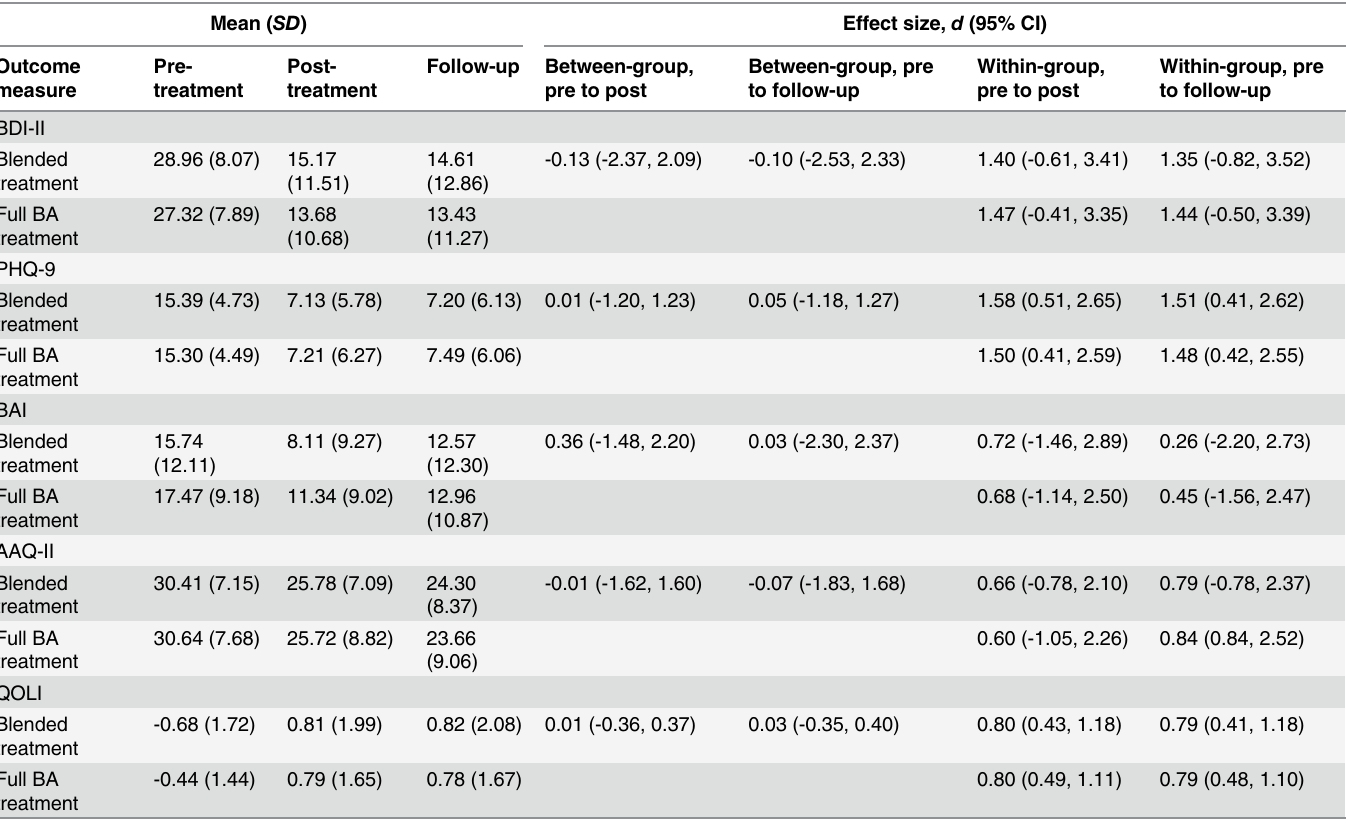
Table 2. Means, SDs and effect sizes (Cohen ’ s d) for measures of depression, anxiety, psychological flexibility and quality of life. Mean ( SD ) Effect size, d (95%